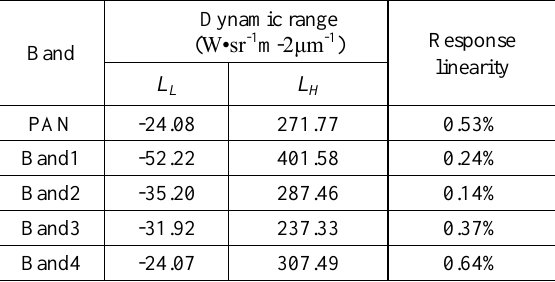
Table 2. Dynamic range and its response linearity for panchromatic and multi-spectral sensors (3) SNR